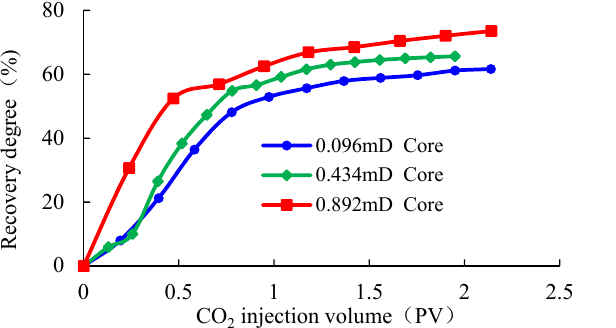
Figure 6. The recovery degree of cores with different permeability under miscible conditions.